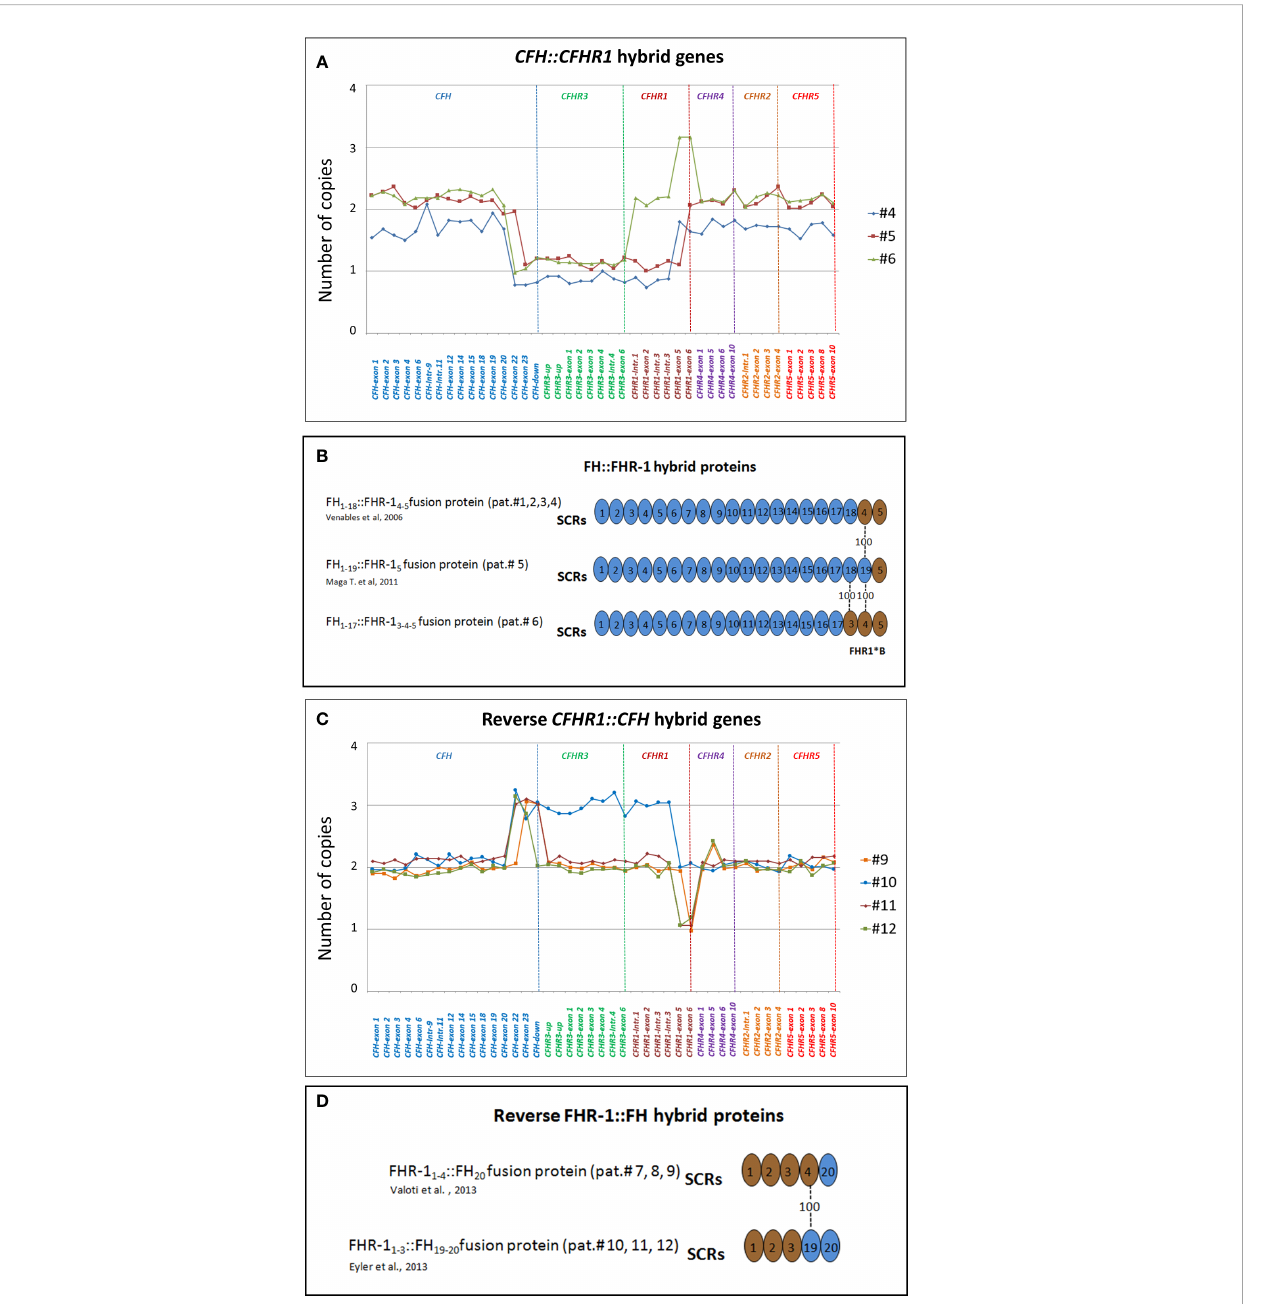
FIGURE 2 Graphic representation of MLPA results from aHUS patients carrying structural variants (SVs) in the CFH and CFHR genes. (A) MLPA patterns consistent with CFH:: CFHR1 hybrid genes. In patient #4, MLPA pattern shows one copy of exons 22 and 23 of CFH , one copy of CFHR3 , one copy of CFHR1 until intron 3, 2 copies of exons 5 and 6 of CFHR1 and two normal copies of CFHR4, CFHR2 and CFHR5 , consistent with CFH 1-21 ::CFHR1 5-6 hybrid gene (29). In patient #5 MLPA results evidence 1 copy of exon 23 of CFH , one copy of CFHR3 , one copy of CFHR1 until exon 5, 2 copies of exons 6 of CFHR1 and two normal copies of CFHR4, CFHR2 and CFHR5 , consistent with CFH 1-22 ::CFHR1 6 hybrid gene (30). In patient #6 MLPA analysis shows one copy of exons 22 and 23 of CFH , one copy of CFHR3 , normal copy number from the CFHR1- intron 1 to CFHR1- intron 3, 3 copies of exons 5 and 6 of CFHR1 , and two normal copies of CFHR4, CFHR2 and CFHR5. This abnormal MLPA pattern was further characterized through long PCR, Sanger sequencing and SMRT which, as reported in Figure 3, led to the identi fi cation of the CFH 1-20 ::CFHR1 4-6 hybrid gene. (B) Representation of FH::FHR-1 hybrid proteins resulting from SVs identi fi ed in patients #1, #2, #3, #4, #5 and #6. SCRs translated from CFH are indicated in blue while SCRs deriving from CFHR1 are indicated in brown. The number “ 100 ” indicates that SCR4 of FHR-1 is identical to SCR19 of FH; similarly, SCR3 of FHR-1*B is identical to SCR18 of FH. The total identity between FH and FHR-1 indicates that the translated FH:: FHR-1 protein is the same in all the above described cases. (C) MLPA pattern consistent with reverse CFHR1::CFH hybrid genes. MLPA results in patient #9 show 3 copies of CFH -exon 23, normal CFHR3 copies, two CFHR1 copies until exon 5, one copy of CFHR1 -exon 6, two normal copies of CFHR4, CFHR2 and CFHR5 , consistent with the reverse CFHR1 1-5 ::CFH 23 hybrid gene. In patient #10, #11 and #12 MLPA analysis shows a gain starting from CFH- exon 22 until CFHR1- intron 3 and a loss of CFHR1 -exon 5-6 consistent with a reverse CFHR1 1-4 ::CFH 22-23 hybrid gene. In addition, patient #10 carries 3 copies of CFHR3 and 2 copies of normal CFHR1. In patient #11 MLPA provides a copy of normal CFHR1 and 2 copies of CFHR3 , consistent with the presence of CFHR1 1-4 -CFH 22-23 on one allele and CFHR3-CFHR1 del on the other allele (see Supplementary Figure 1). Unlike patient #11, the abnormal MLPA pattern of patient #12 does not involve the probe located downstream of CFH . (D) Representation of reverse FHR-1::FH hybrid proteins resulting from SVs identi fi ed in patients #7, #8, #9, #10, #11 and #12. The translated fusion protein is the same in all cases due to the 100% of identity between SCR19-FH and